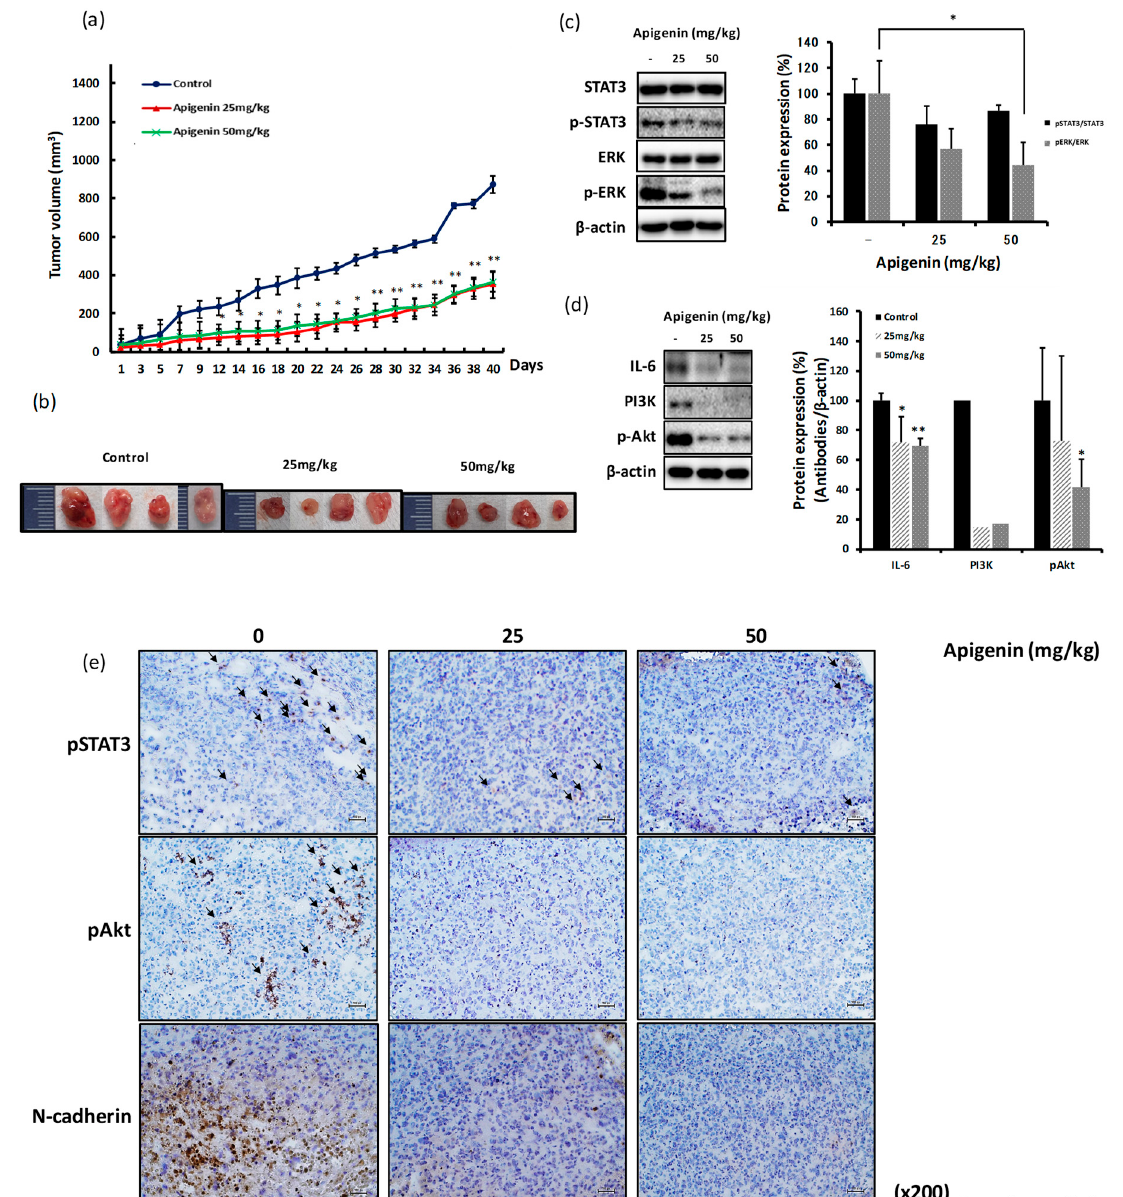
Figure 7. The inhibitory e ff ect of apigenin on the growth and metastasis of a MDA-MB-231 cell-derived tumor is mediated through the reduced expression of pSTAT3, pERK, IL-6, and pAkt. BALB / c nude mice were subcutaneously injected with 5 × 10 6 MDA-MB-231 cells into the dorsum next to right hind leg. After 14 days, the mice were orally administrated drinking water or apigenin (25 or 50 mg / kg) every day for another 2 weeks. Tumor size was measured by caliper every other day. ( a ) Tumor growth curve. ( b ) Tumor photograph. ( c,d ) Expression of proteins in tumor tissues analyzed by western blotting. ( e ) Expression of proteins in tumor tissues analyzed by immunohistochemistry (IHC). Expression of STAT3 (and pSTAT3), ERK (pERK), PI3K, and pAkt proteins (c,d). Black arrows indicate the dots of pSTAT3, pAkt, and N-cadherin (e) (scale value is 100px). Significant di ff erences are shown: * p < 0.05, ** p <